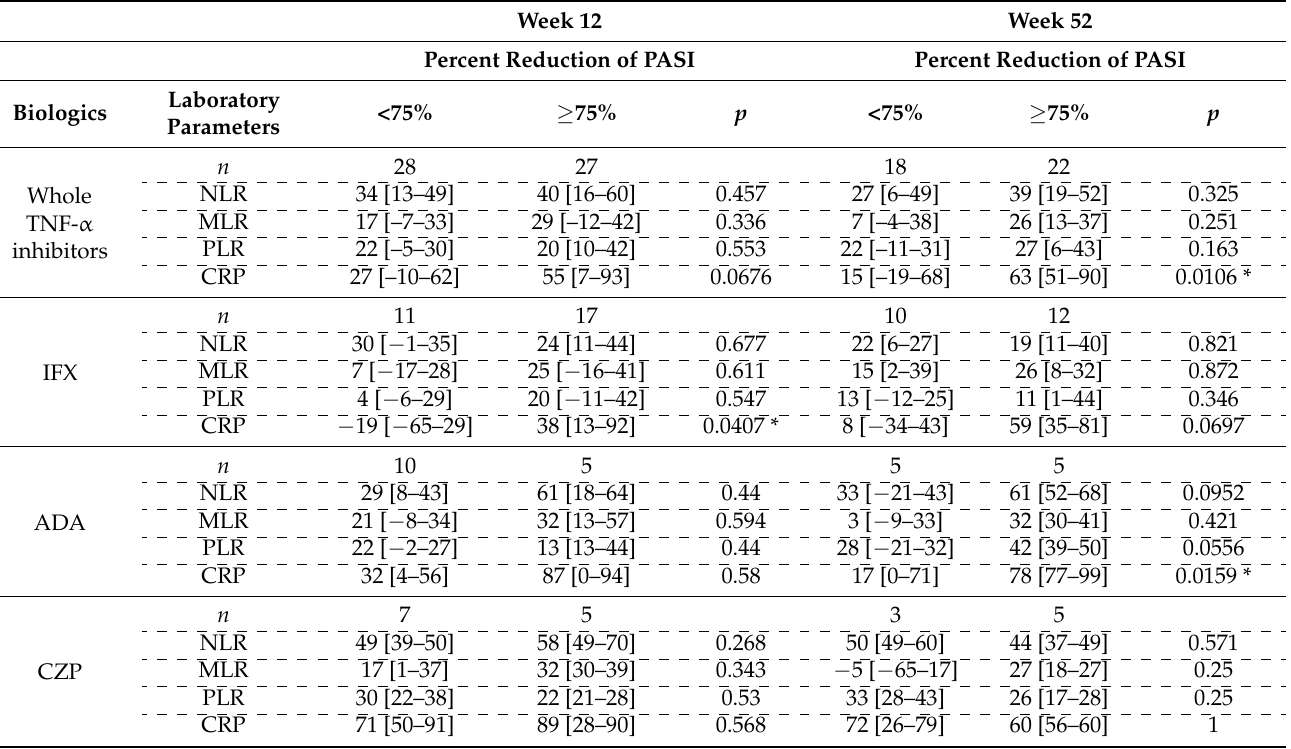
Table 5. Percentage reductions of laboratory parameters in high responders versus low responders during treatment with tumor necrosis factor (TNF)-a